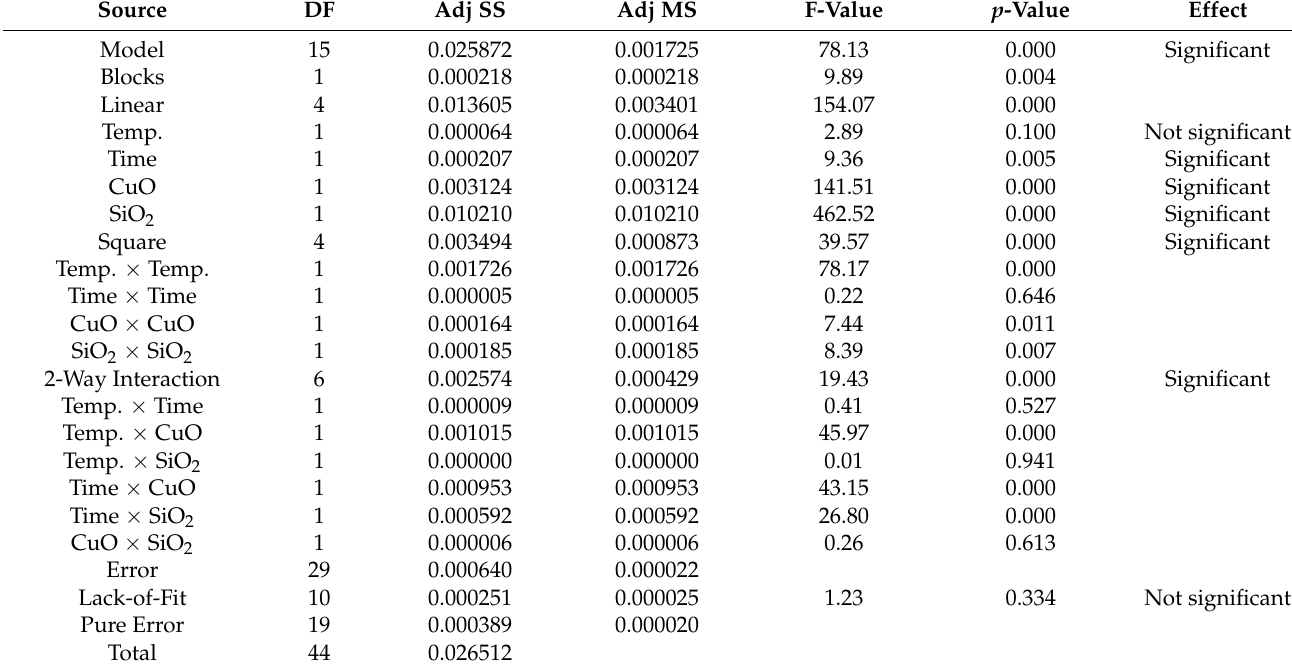
Table 9. The Density Analysis of Variance by RSM